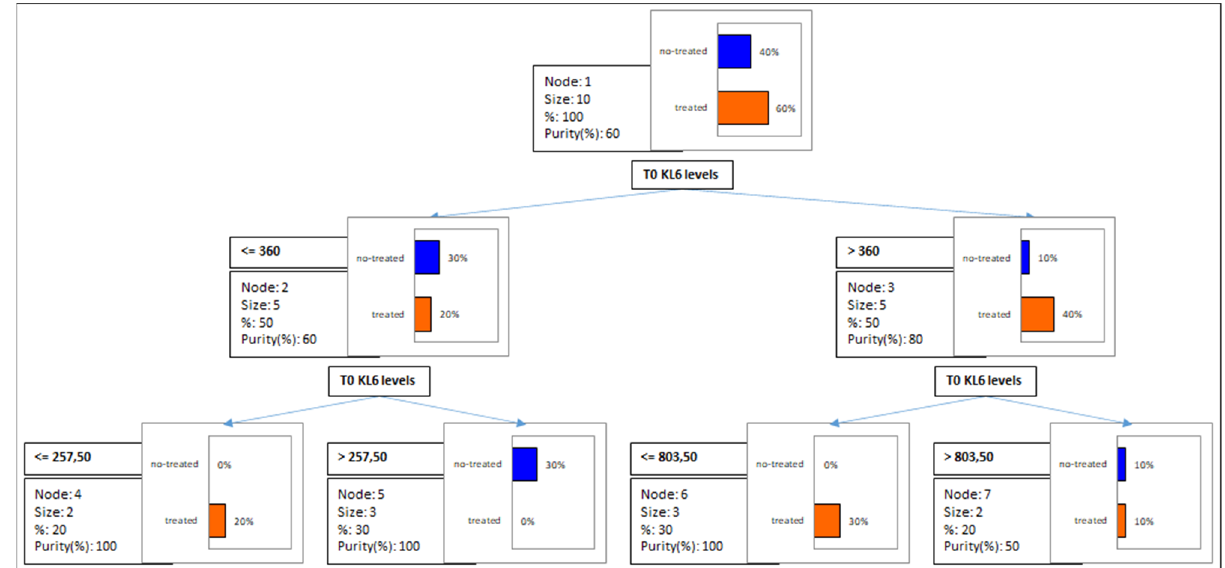
Figure 3. Decision tree model obtained from KL6 concentrations in AAV patients stratified according to previous treatment: 20% improvement in class purity for treated patients with a cut-off value of 360 U/mL and also with a further cut-off of 803.5 U/mL. The non-treated group used for the model obtained a 40% improvement in purity with a serum KL6 cut-off value of 257.5 U/mL. For clinical parameters, a direct correlation was found between serum concentrations of KL-6 at T0 and T0 BVAS (r = 0.578, p = 0.044) (Figure 4).